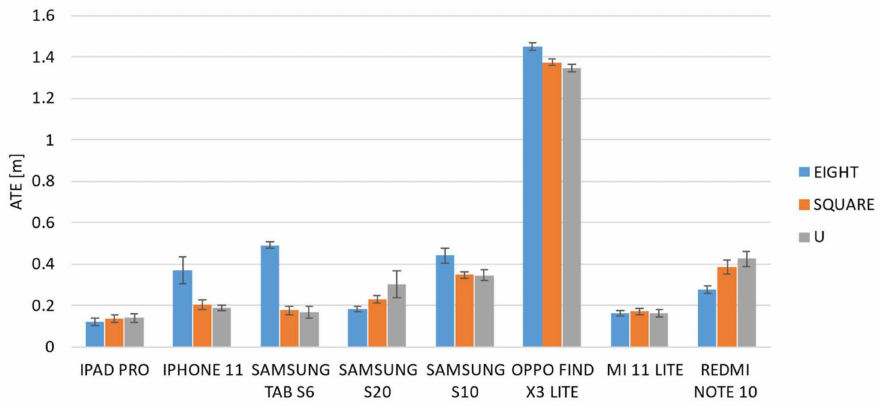
Figure 8. Averaged ATE for the selected devices over the three paths (eight-, square-, and U-shaped